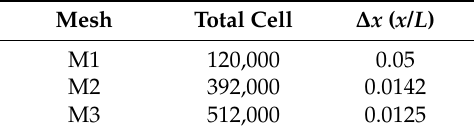
Figure 8. The numerical solutions of velocity components through the horizontal centerlines with Wi = 1.0, comparing between the results of GAC and the AC, respectively. Table 1. Mesh characteristics used in this study.